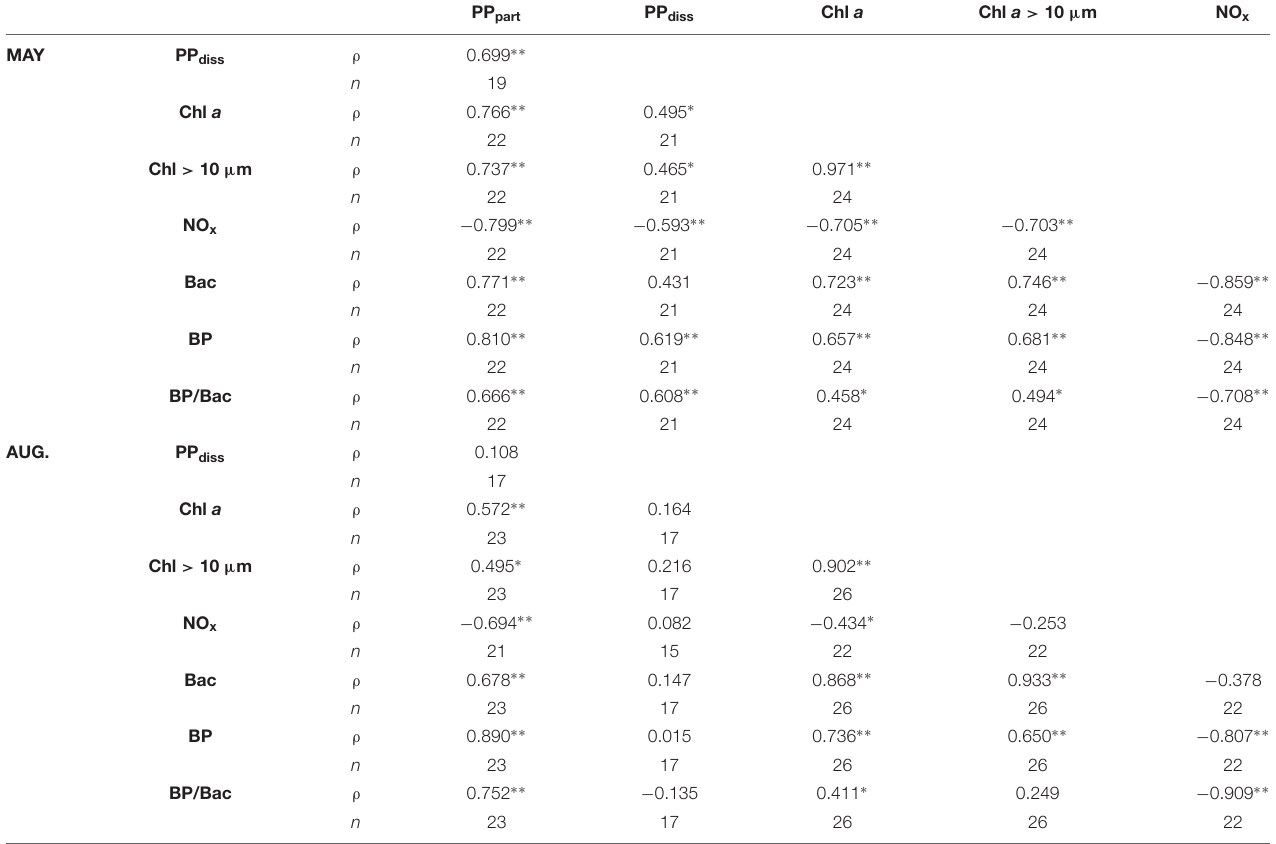
TABLE 3 | Correlation matric (non-parametric Spearman’s rho, ρ ) of particulate primary production (PP part ), dissolved primary production (PP diss ), total chlorophyll a (Chl a ), Chl a > 10 µ m, concentration of nitrate, nitrite and ammonium (NO x ), bacterial abundance (Bac), bacterial production (BP) and cell-specific bacterial production (BP/B) in May and August.